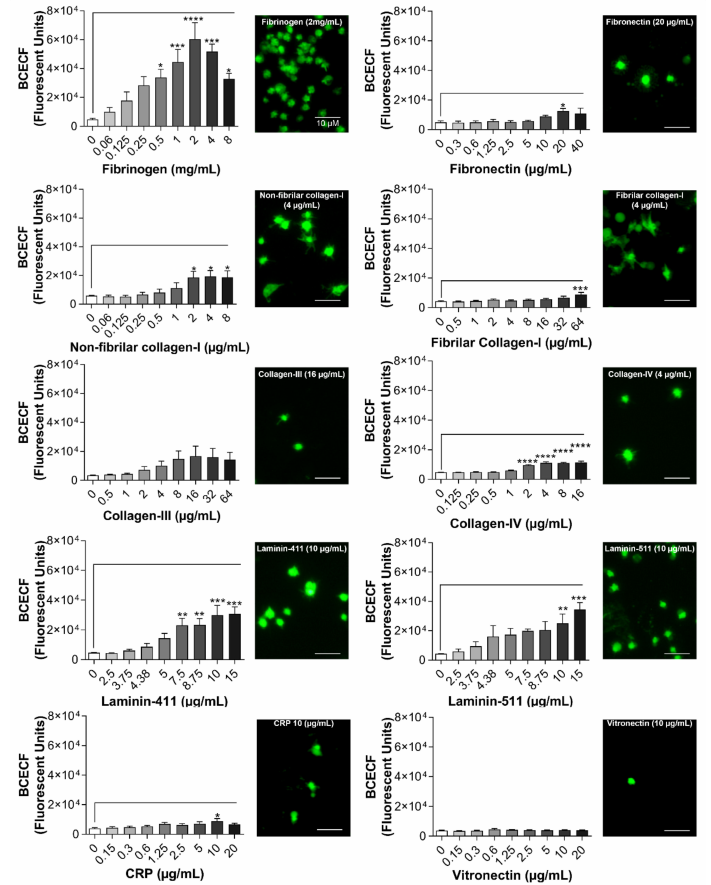
Figure 3. Platelet adhesion on di ff erent ECM proteins measured by BCECF-AM. Coating of 96-well microplates with ECM proteins (50 µ L) was performed for 1 h at 37 ◦ C. Di ff erent proteins and concentrations of ECM were used: fibrinogen (0.06 to 8 mg / mL); fibronectin (0.3 to 40 µ g / mL); non-fibrillar collagen-I (0.06 to 8 µ g / mL); fibrillar collagen-I (0.06 to 8 µ g / mL); collagen-III (0.5